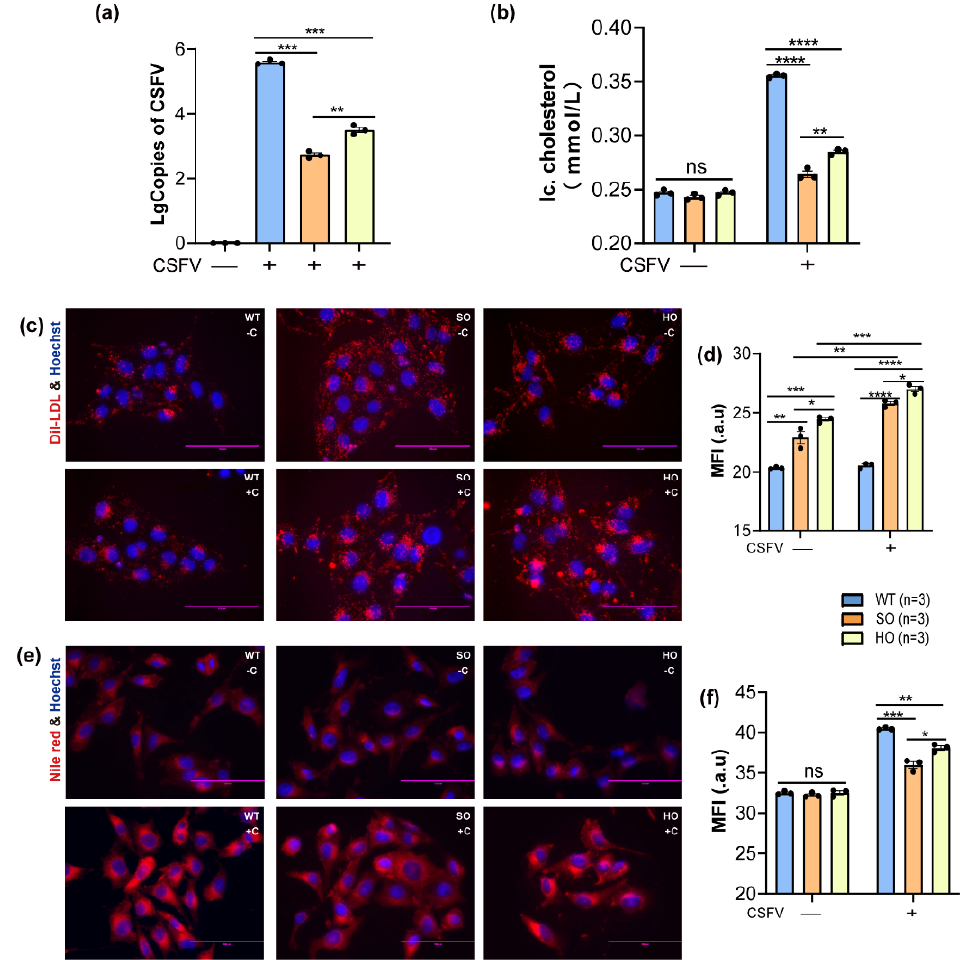
Figure 4. Cholesterol biosynthesis regulates CSFV replication in PK-15 cells . ( a , b ) The disruption of cholesterol biosynthesis effectively reduced intracellular cholesterol contents and CSFV replication; n = 3; ** p < 0.01; *** p < 0.001; **** p < 0.0001. ( c , d ) The deficiency of cholesterol biosynthesis upregulated dil-LDL uptake and decreased intracellular cholesterol levels; n = 3; * p < 0.05; ** p < 0.01; *** p < 0.001; **** p < 0.0001. ( e , f ) (WT, wild-type; SO, sqle-ko; HO, hsd17b7-ko; Ic. cholesterol, intracellular cholesterol level; MFI, mean fluorescent